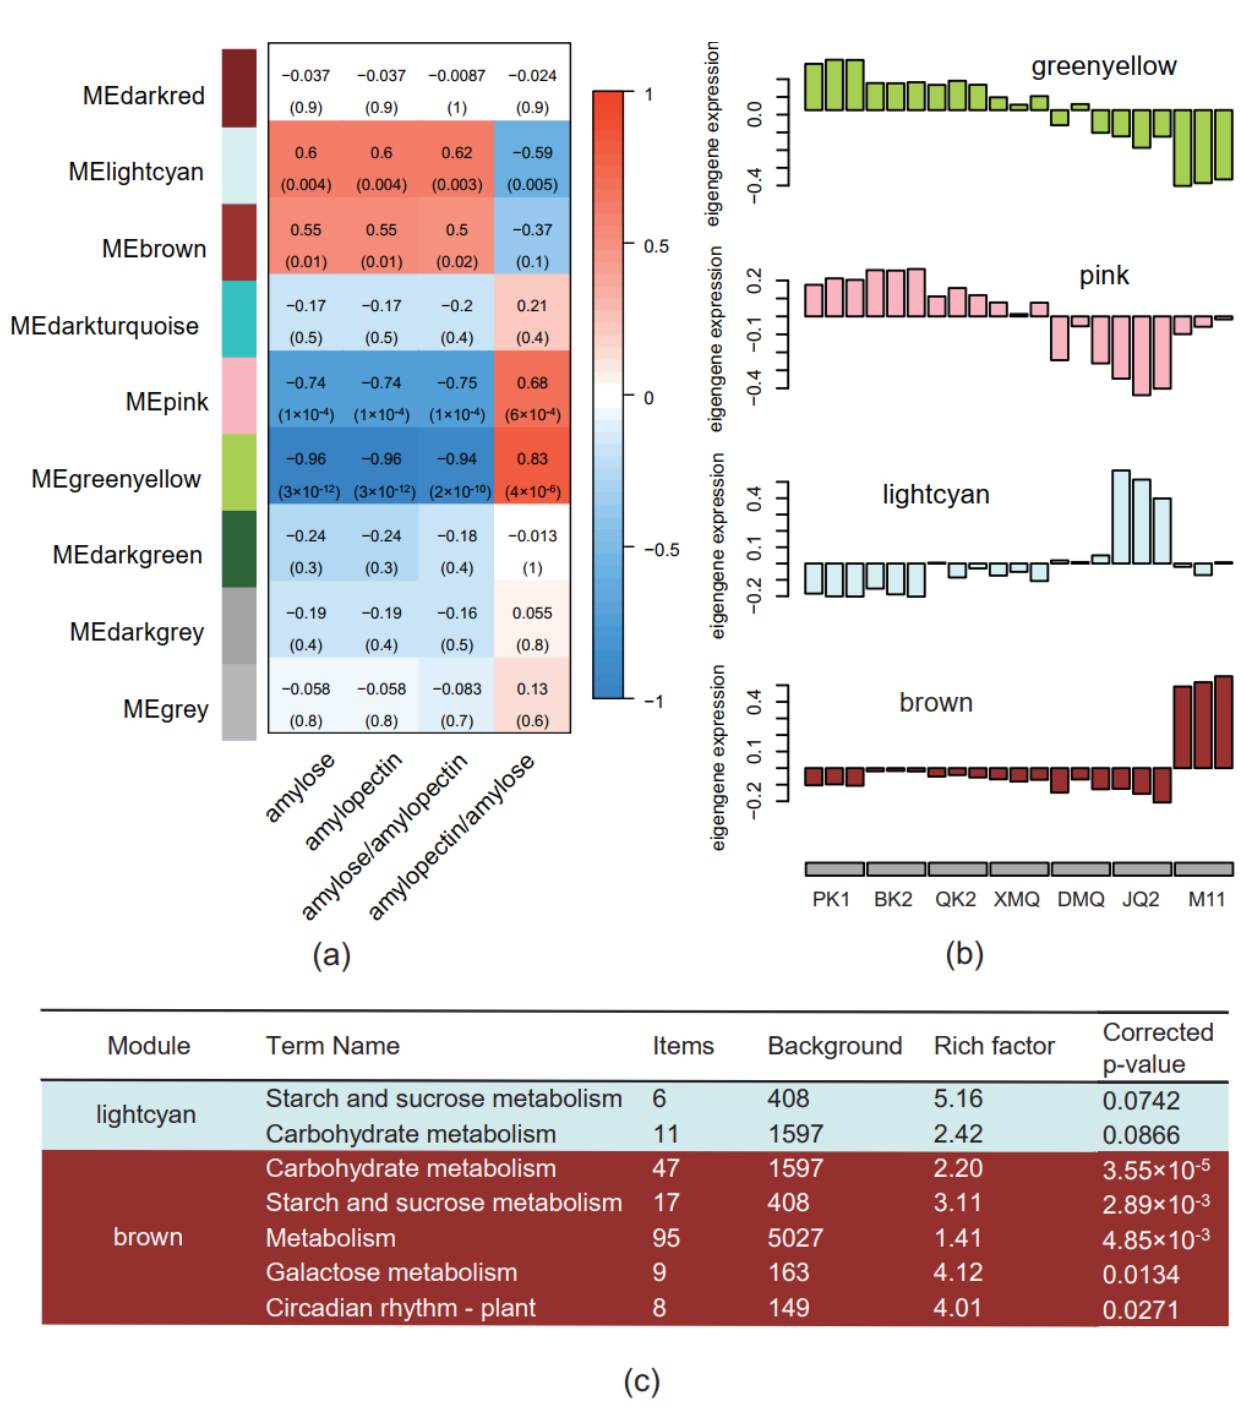
Figure 4. Weighted gene correlation network analysis (WGCNA) for DEGs and the enriched pathways of trait-specific modules in Tartary buckwheat seeds. ( a ) Module–trait relationships by WGCNA analysis. The correlations and the corresponding p -values (in parentheses) are indicated in the heatmap. The panel on the left side shows nine identified modules. amylose/amylopectin is shorten for the ratio of amylose to amylopectin; amylopectin/amylose is short for the ratio of amylopectin to amylose; ( b ) Expression patterns of the trait-specific modules ( p -value < 0.05) in correspondence to the module–trait relationship heatmap; ( c ) KEGG enrichment analysis of the lightcyan and brown modules. Rich factor is the ratio of the number of DEGs to that of all genes annotated to a pathway term. A higher rich factor indicates greater intensity.